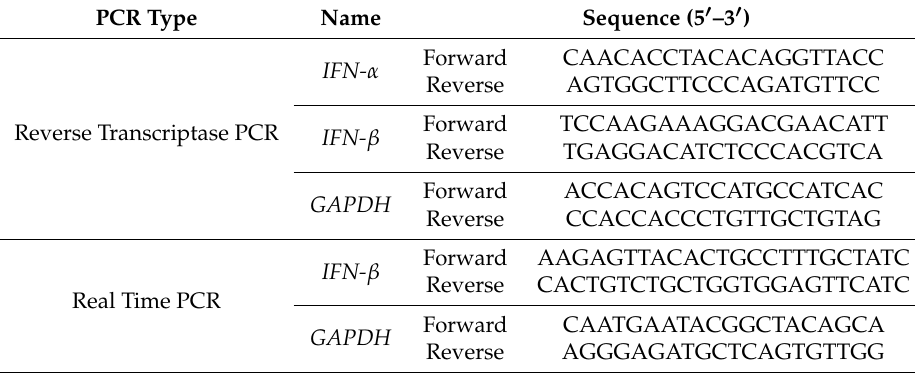
Table 1. Primer sequences used for PCR in this